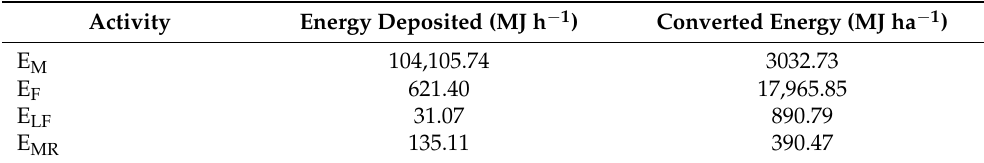
Table 5. Conversion of deposited energy in materials, manufacturing, and transportation (E M ), fuel (E F ), lubricants and filters (E LF ), and maintenance and repair (E MR ) from MJ h − 1 to MJ ha − 1 from the field productivity factor of 2.89 h ha − 1